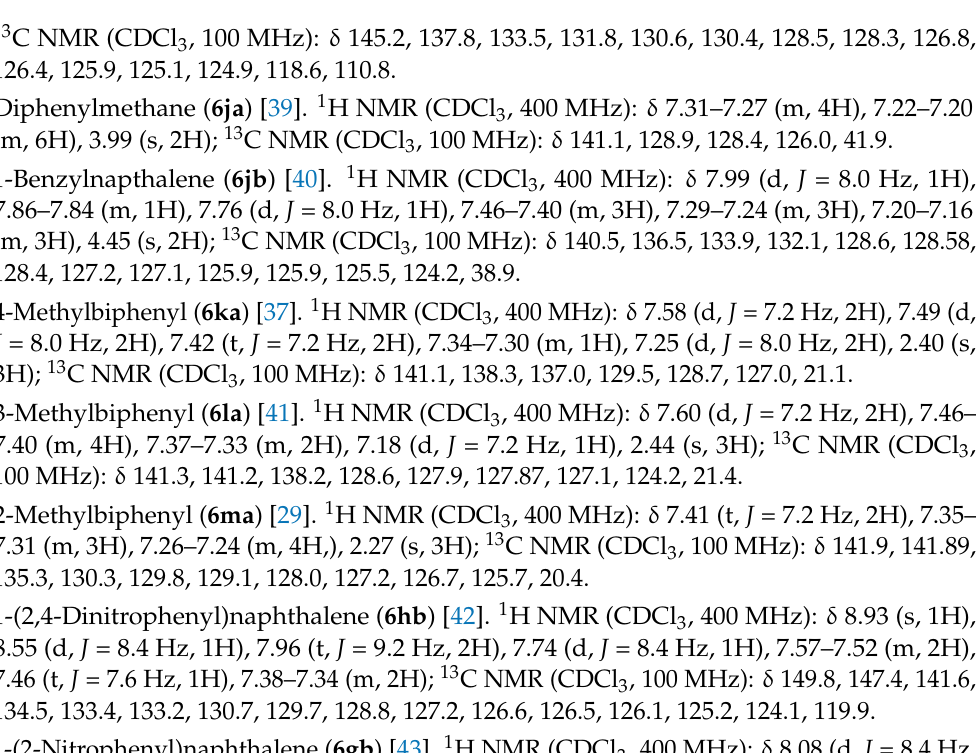
S1 in CDCl 3 , Figure S2: 13 C NMR spectrum of 2-(2 (cid:48) ,4 (cid:48) ,6 (cid:48) -trimethylanilido)nitrobenzene S1 in CDCl 3 , Figure S3: 1 H NMR spectrum of N -(2 (cid:48) ,4 (cid:48) ,6 (cid:48) -trimethylphenyl)-1,2-phenylenediamine S1 in CDCl 3 , Figure S4: 13 C NMR spectrum of N -(2 (cid:48) ,4 (cid:48) ,6 (cid:48) -trimethylphenyl)-1,2-phenylenediamine S2 in CDCl 3 , Figure S5: 1 H NMR spectrum of 1-(2,4,6-trimethylphenyl)-1 H -benzimidazole 2b in CDCl 3 , Figure S6: 13 C NMR spectrum of 1-(2,4,6-trimethylphenyl)-1 H -benzimidazole 2b in CDCl 3 , Figure S7: 1 H NMR spectrum of (3,3 (cid:48) -(1,3-phenylenebis(methylene))bis(1-(4-methoxyphenyl)-1 H - benzo[d]imidazol-3-ium)) dibromide ( 3a ) in DMSO-d 6 , Figure S8: 13 C NMR spectrum of (3,3 (cid:48)